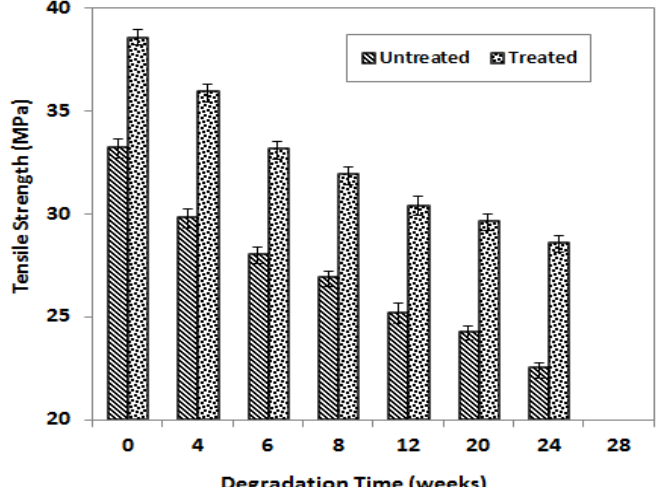
Figure 12: Tensile strength degradation of the optimized composites (45% fiber) in soil medium.